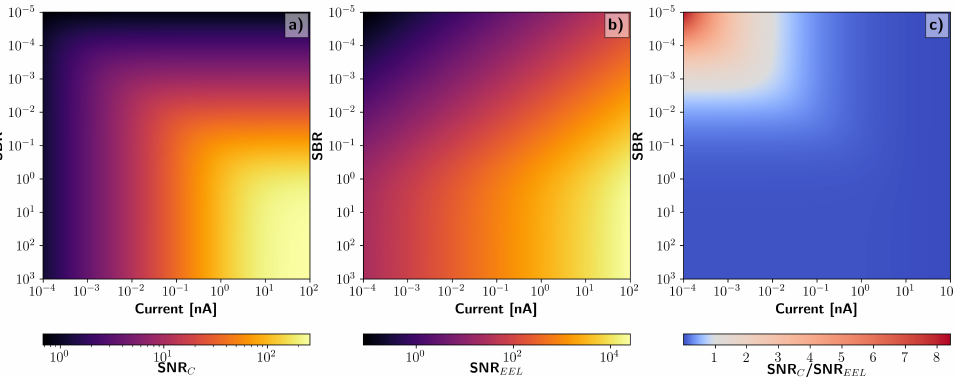
Figure 6. ( a , b ) The SNR of the coincidence and conventional EELS while varying the SBR and I and keeping the exposure time constant. Please note that both axes are logarithmic. The other parameters used to determine the SNR are indicated in Table A1. ( c ) The ratio between the SNR of coincidence and conventional EELS where a value larger than one indicates the region where coincidence outperforms conventional EELS (red colored